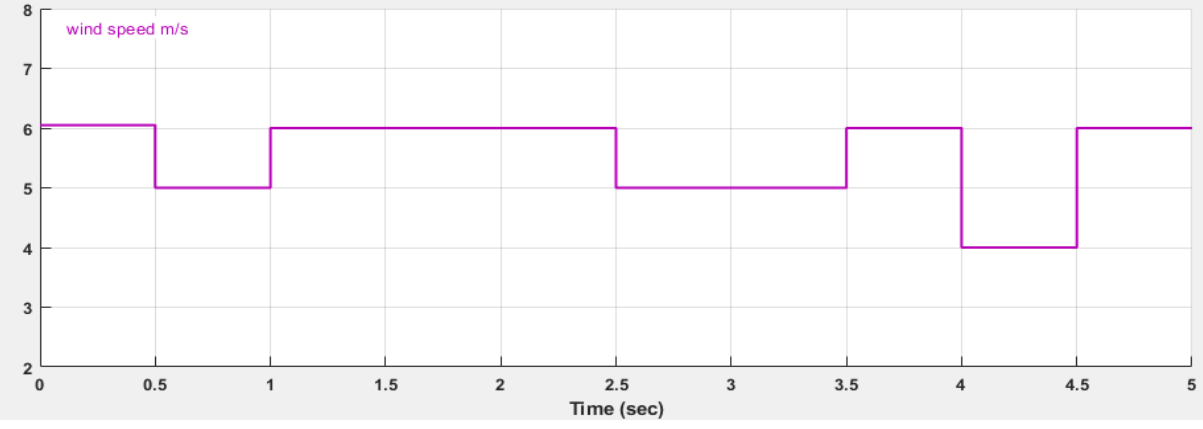
Figure 9. Wind speed.